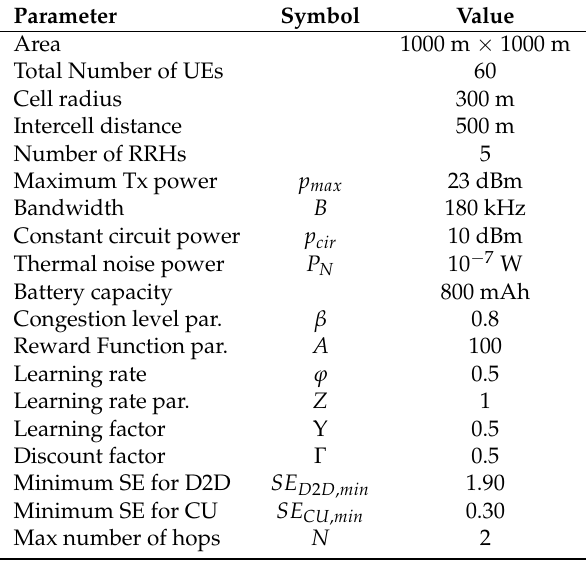
Table 3. Simulation parameters and their